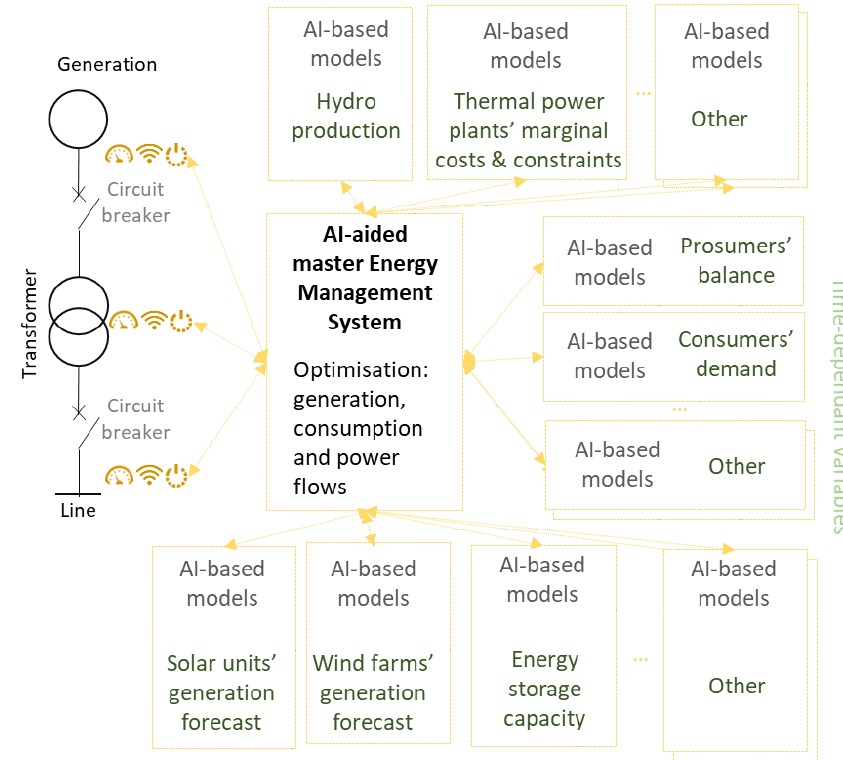
Figure 6. AI-aided Energy Management System.